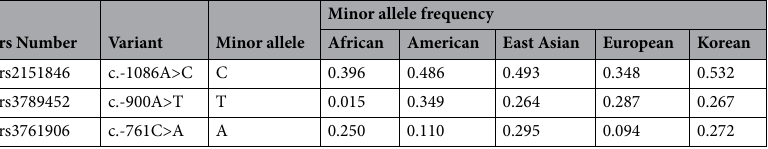
Table 1. Frequencies of ABCA4 proximal promoter variants. African, American, East Asian, and European data was obtained from the 1000 Genomes Project (phase 3) and Korean data was obtained from the KRG Database.